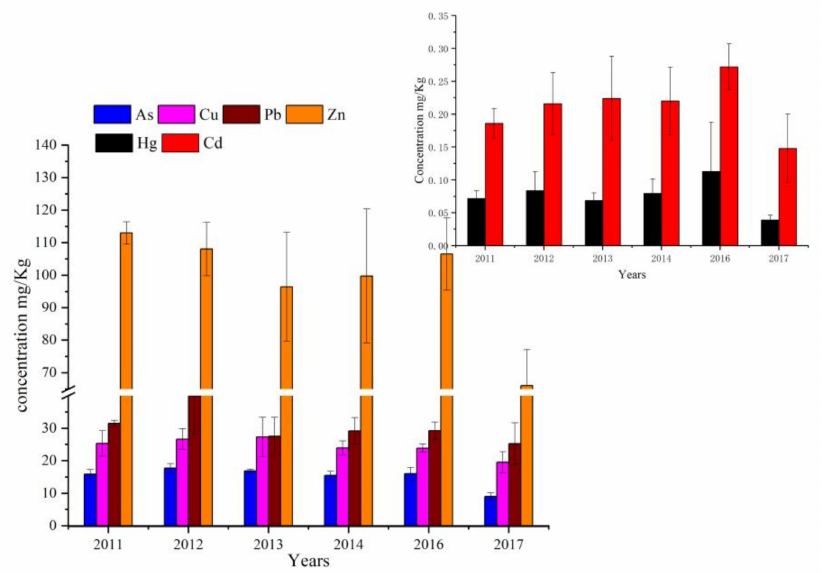
Figure 2. Average concentrations of HMs in surface sediments in different years.